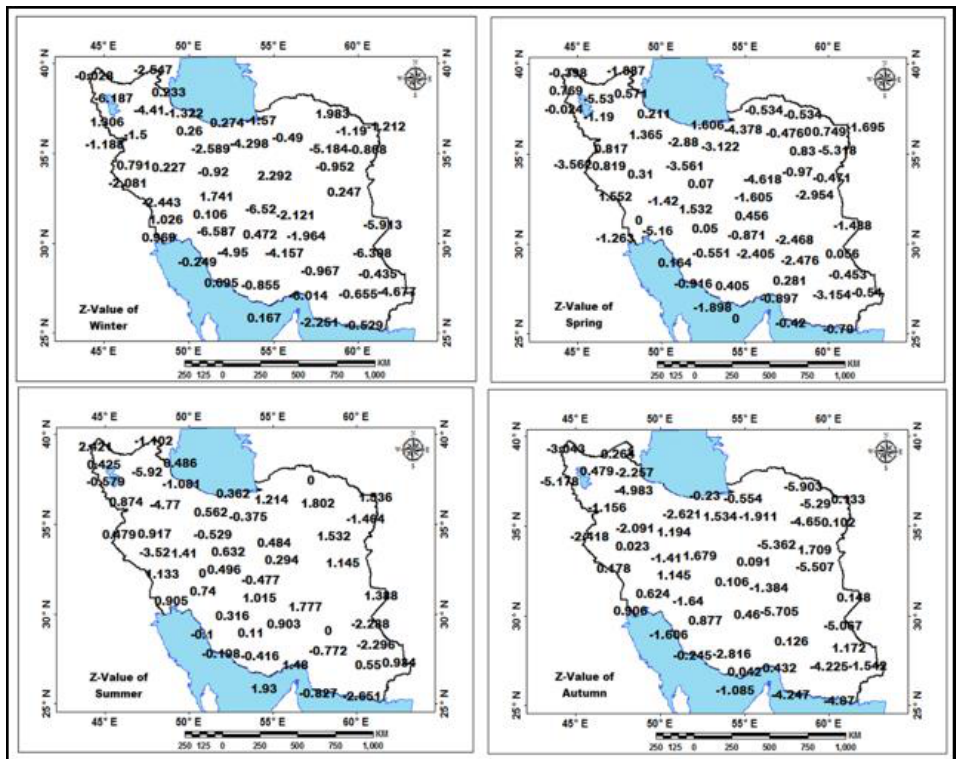
Figure 10. Seasonal trend analysis of rainfall in Iran.